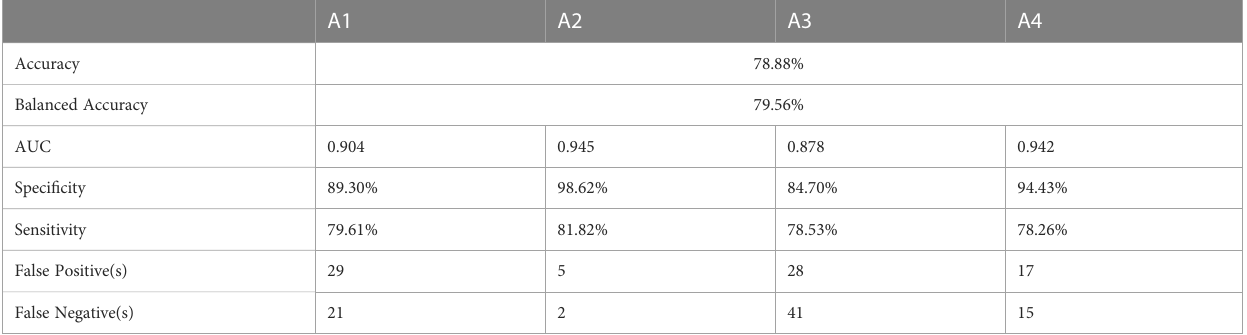
TABLE 3 Fracture classi fi cation test evaluation in the test dataset.